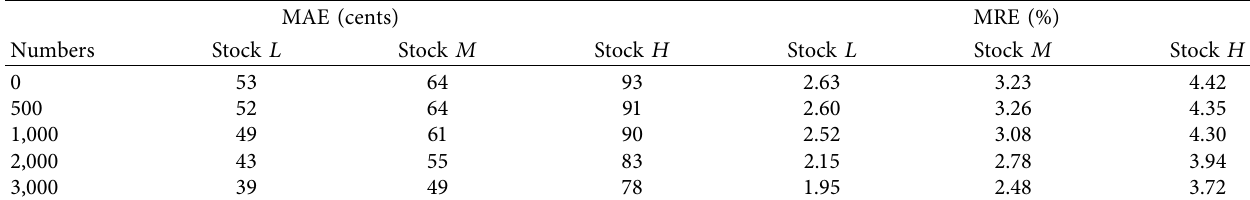
Table 13: Impact of futures and cash arbitrageurs on price efficiency in the spot market.